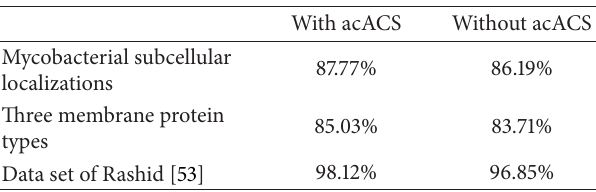
Table 2: The comparison of the results with and without the acACS for predicting mycobacterial subcellular localizations and three membrane protein